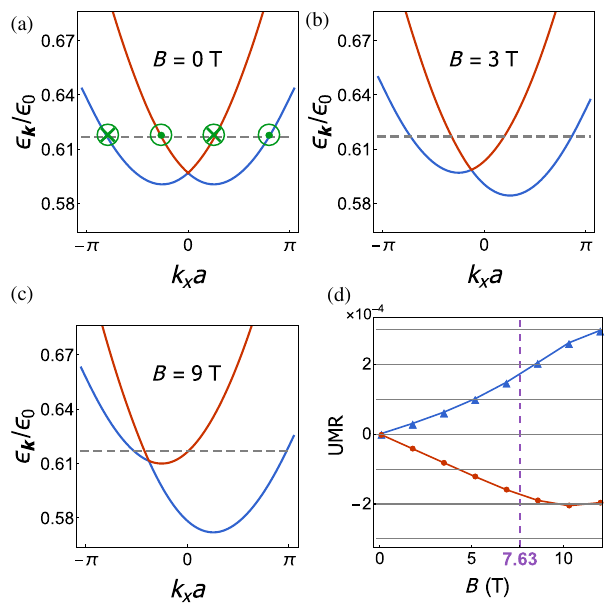
FIG. 5. Mechanism of UMR sign change. Structure of the ¼ 0 and (a) 0 T, (b) 3 T, and (c) 9 T, conduction bands at k y indicating the breaking of time-reversal symmetry induced by the magnetic field. The two bands are shown here in red and blue, with the dashed line indicating the Fermi level. (d) Opposite contribu- tions of the inner (red dots) and outer (blue triangles) conduction bands to the UMR, with the purple dashed line indicating the field at which the sign change in the overall UMR